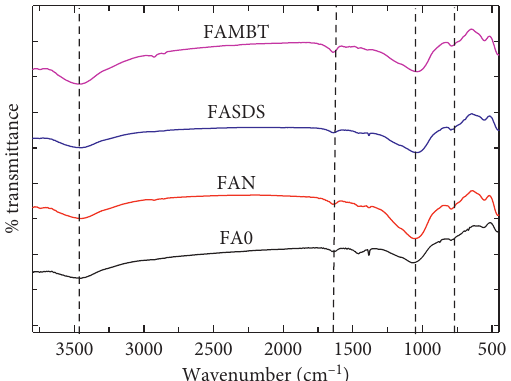
Figure 1: FTIR spectra of FA0, FAN, and modified FAN particles. Table 1: Position of main peaks in FTIR spectra of FA0, FAN, and modified FAN particles. Sample